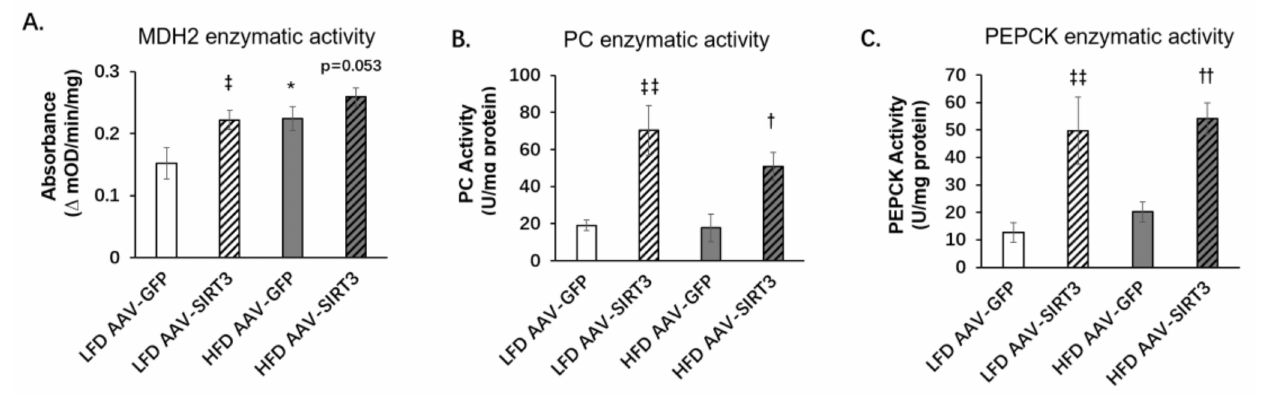
Figure 7. SIRT3 overexpression increases the activities of gluconeogenic enzymes. C57BL/6N male mice of 5–6 weeks of age were injected with AAV-GFP or AAV-SIRT3 via a tail vein and fed with LFD or HFD for 12 weeks. At the 14th week of feeding, mice were euthanized, and the liver tissues were collected. ( A ) Enzymatic activity of MDH2. ( B ) Enzymatic activity of PC. ( C ) Enzymatic activity of PEPCK. The data are mean ± s.e. (error bars). n = 4–7 mice per group *, p < 0.05, LFD AAV-GFP vs. HFD AAV-GFP; ‡, p < 0.05, ‡‡, p < 0.01, LFD AAV-GFP vs. LFD AAV-SIRT3; †, p < 0.05, ††, p < 0.01, HFD AAV-GFP vs. HFD